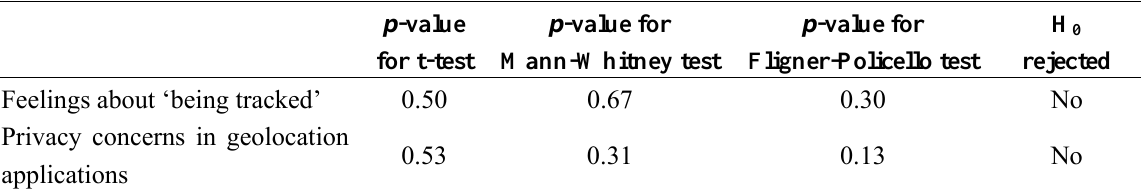
Table 7. Correlation between TUT and UPB groups regarding privacy in the context of LBS.